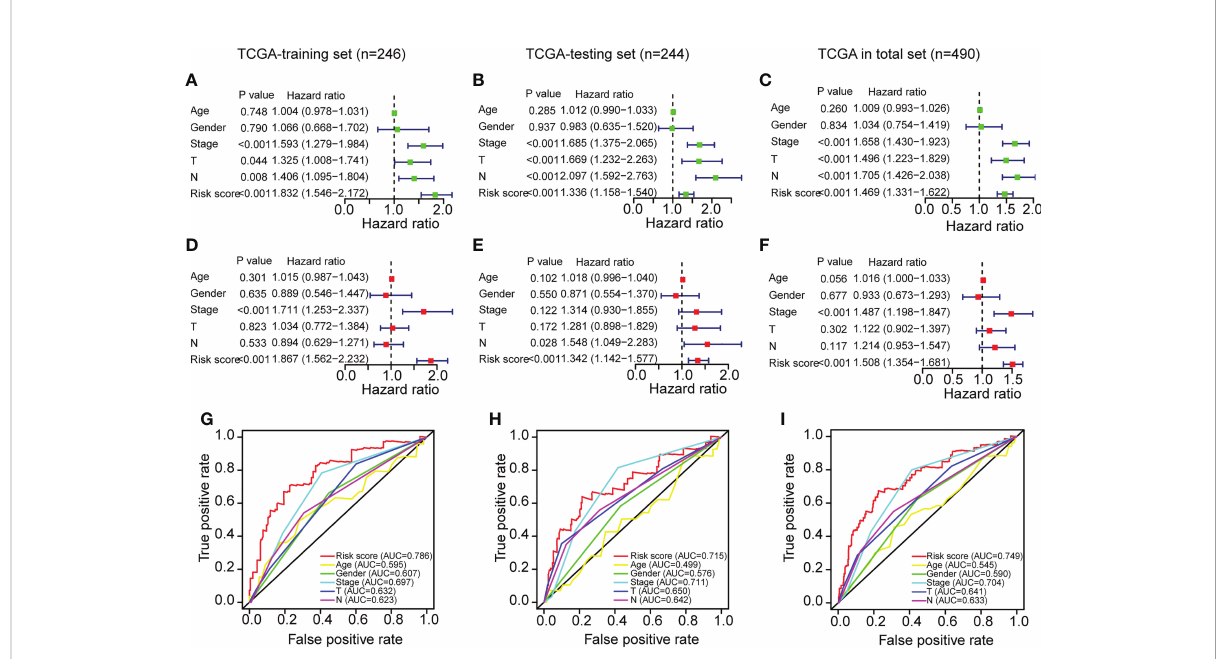
FIGURE 4 Independent prognostic power evaluation of the ERS in the three sets of TCGA-LUAD cohort. (A – C) Analyses of univariate Cox regression revealed that both the risk score and clinical variables were associated with a poor prognosis. (D – F) Multivariable Cox regression analyses con fi rmed the independent prognostic value of the ERS compared to other clinical factors. (G – I) Multivariate ROC analysis indicated that the risk score had prognostic predictive signi fi cance for LUAD